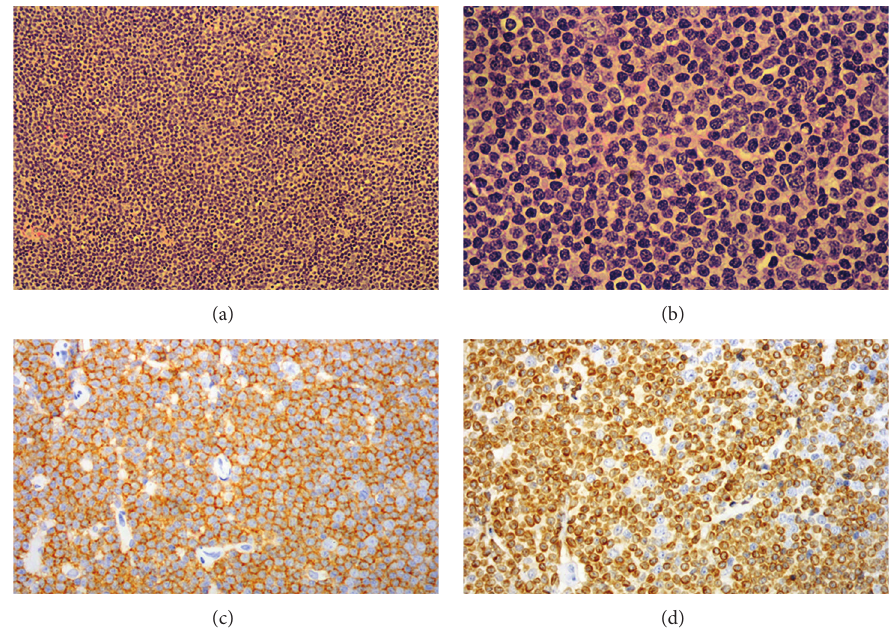
Figure 3: Infiltrate of vocal cord by small sized lymphoid cells on H&E ((a) and (b)), positive for CD20 (c) and bcl-2 (d) on